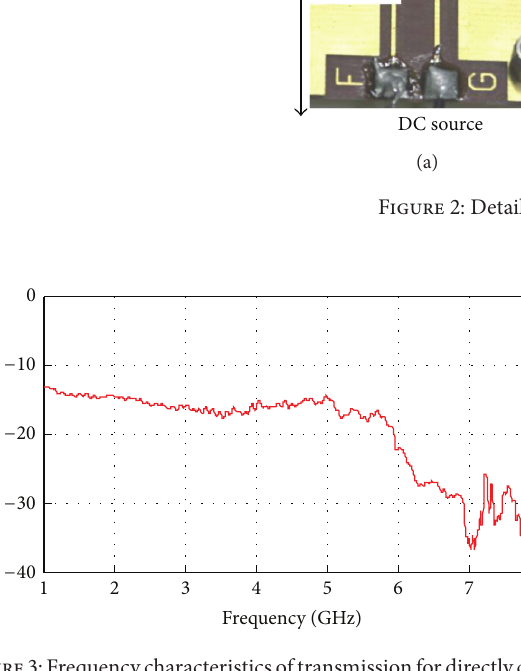
Figure3:Frequencycharacteristicsoftransmissionfordirectlycon- nected E/O and O/E converters.